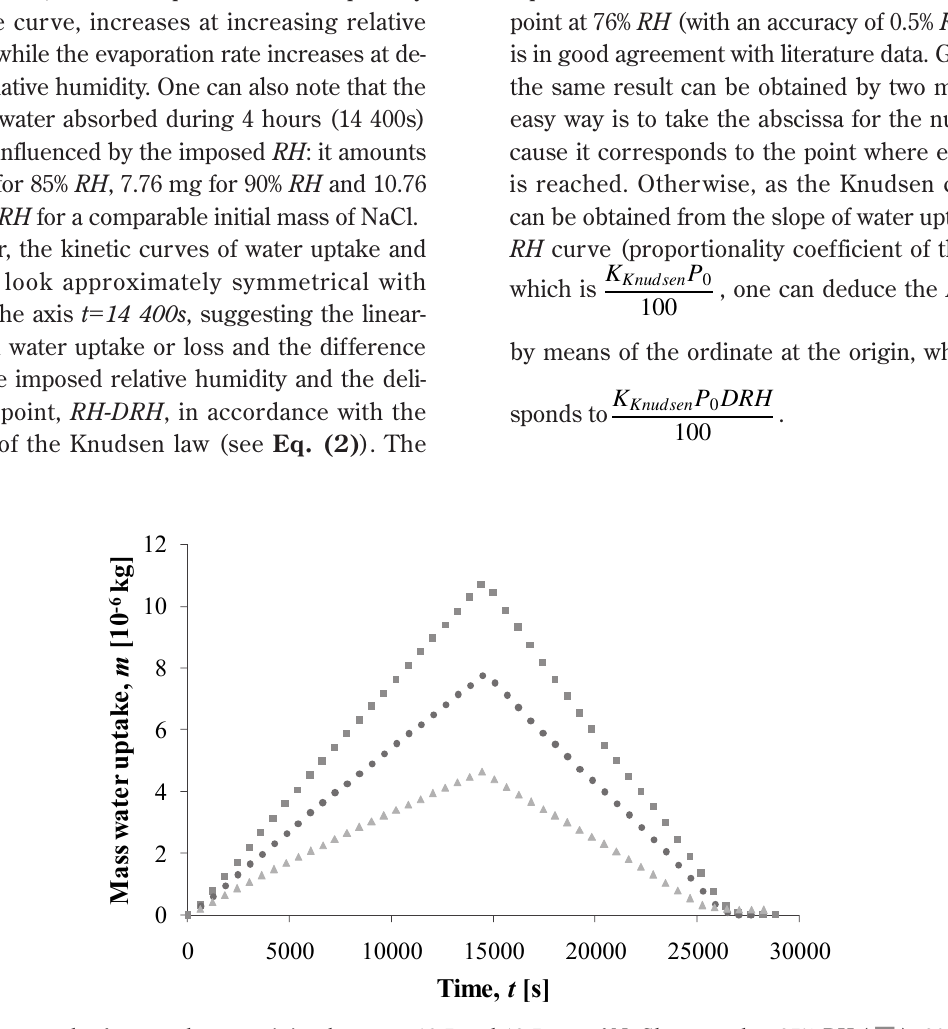
Fig. 6 Water uptake for samples containing between 12.5 and 13.5 mg of NaCl exposed to 95% RH ( ■ ), 90% RH ( ● ) and 85% RH ( ▲ ) and water loss at 55% RH ( ■ ), 60% RH ( ● ) and 65% RH ( ▲ ) at 25